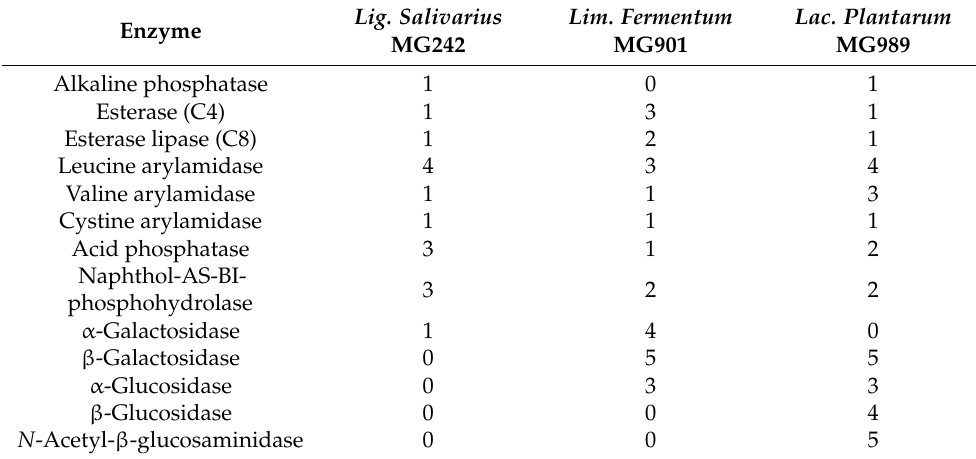
Table 3. Enzymatic activity of the LAB, as measured using an API ZYM system. Lig. Salivarius Enzyme